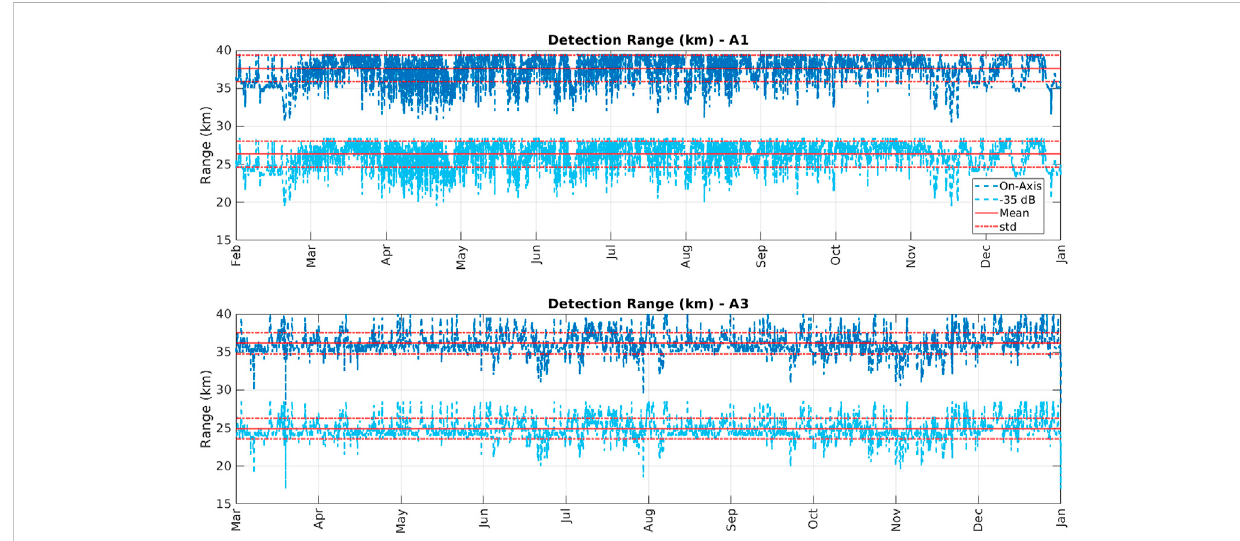
FIGURE 4 Modeled detection ranges for on-axis (dark blue) and off-axis ( − 35 dB; light blue) sperm whale echolocation signals at station A1 (top) and A3 (bottom). Red lines indicate the mean values; red dashed lines indicate the standard deviation from the mean.